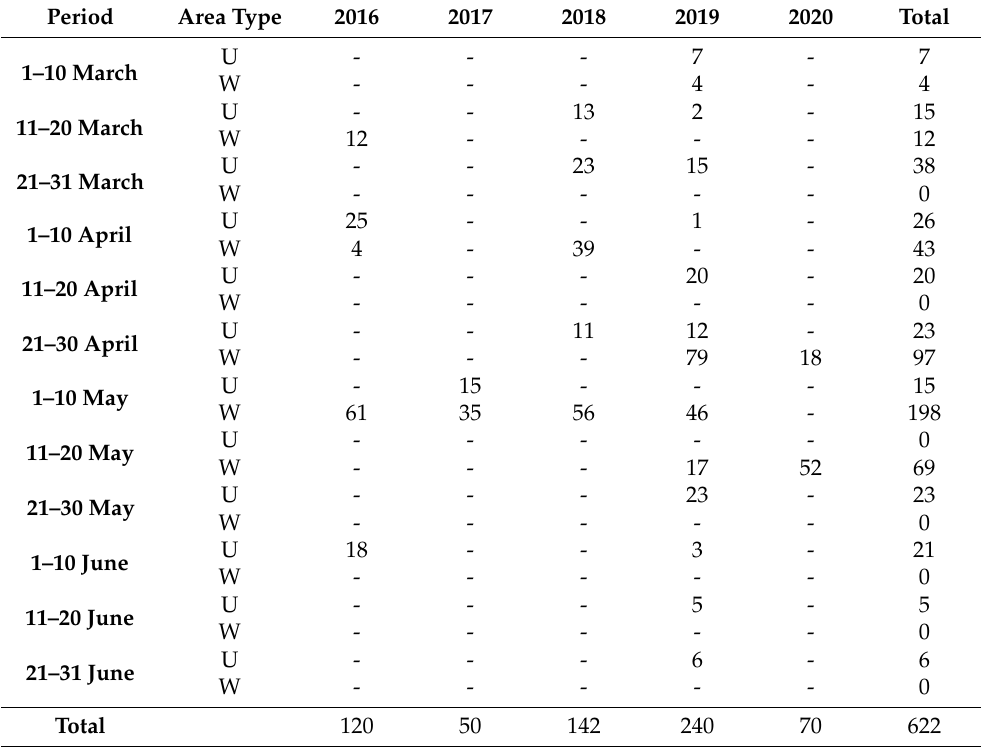
Table 3. Collected ticks ( n ) in urbanized and wild sampling sites over the 5 years by 10 days period from March to June.